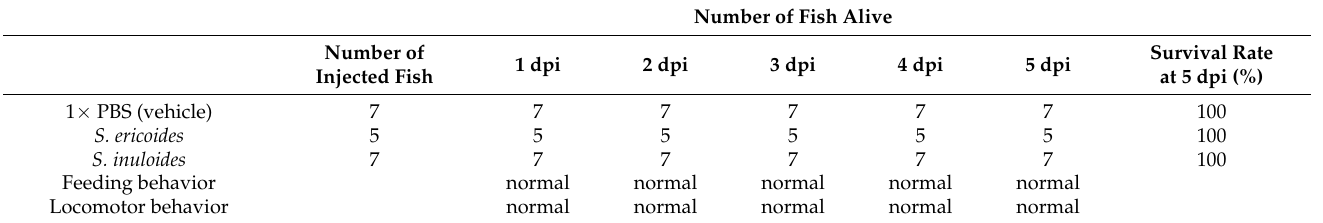
Table 1. Survival and fish behavior after being injected with S. ericoides and S. inuloides , from day 1 post-injection to day 5 post-injection (dpi).